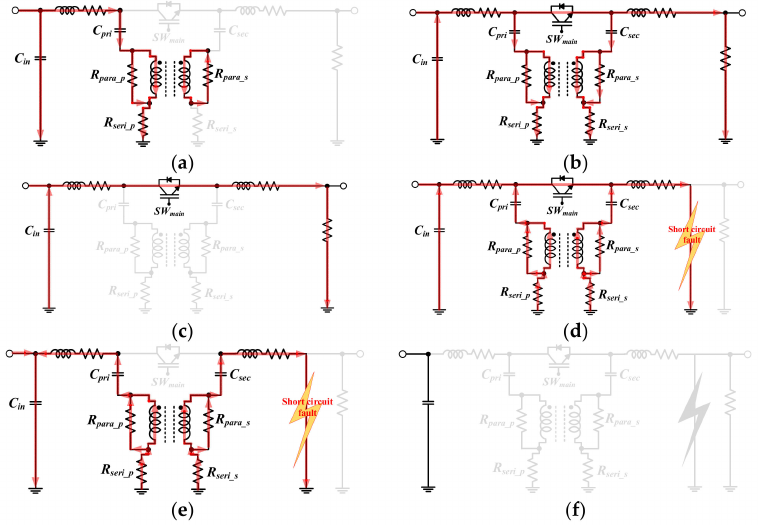
Figure 2. Operation states of SSCB-CI. ( a ) State 1: pre-charge of primary winding capacitor. ( b ) State 2: pre-charge of secondary winding capacitor. ( c ) State 3: stationary. ( d ) State 4: time interval. ( e ) State 5: block and commutation. ( f ) State 6: protection.